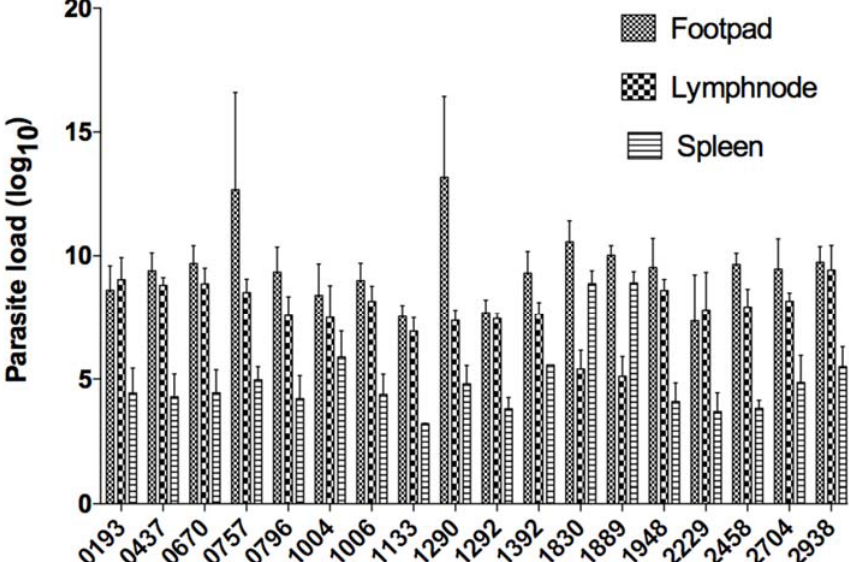
Figure 2. Parasite load in whole infected footpads, spleens, and lymph nodes of BALB/c mice infected with the 18 L. major isolates. For each one of the 18 isolates included in the study, a group of six BALB/c mice were sacrificed on the eighth week after infection (excluding isolate 0796 that was sacrificed on the sixth week after infection) and parasite load in three organs (infected footpad, lymph node draining the infection site, and spleen) was determined by limiting dilution assay. The results are expressed as the means ± standard deviations of the log 10 dilutions of infected footpads, draining popliteal lymph nodes, or spleens that were positive for L. major promastigotes. The results represent triplicates from six individuals in each group. The results correspond to those obtained from one representative experiment out of two performed.